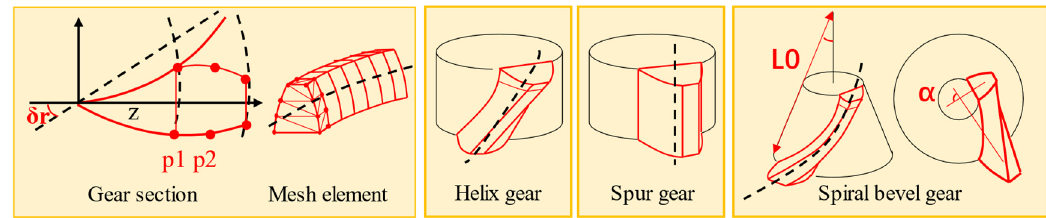
Figure 10. Process of mesh solid modelling of gear.